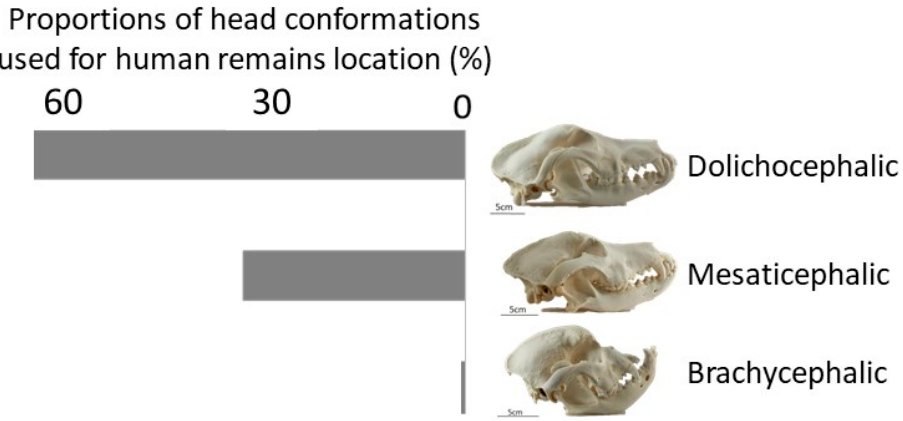
Figure 3. Proportions of dogs declared to be used as human remains detection dogs in our survey (N = 10 out of 16 brigades) belonging to the three common types of dog’s skull conformation (skull pictures are reproduced with the kind permission of Tibor Csörg).